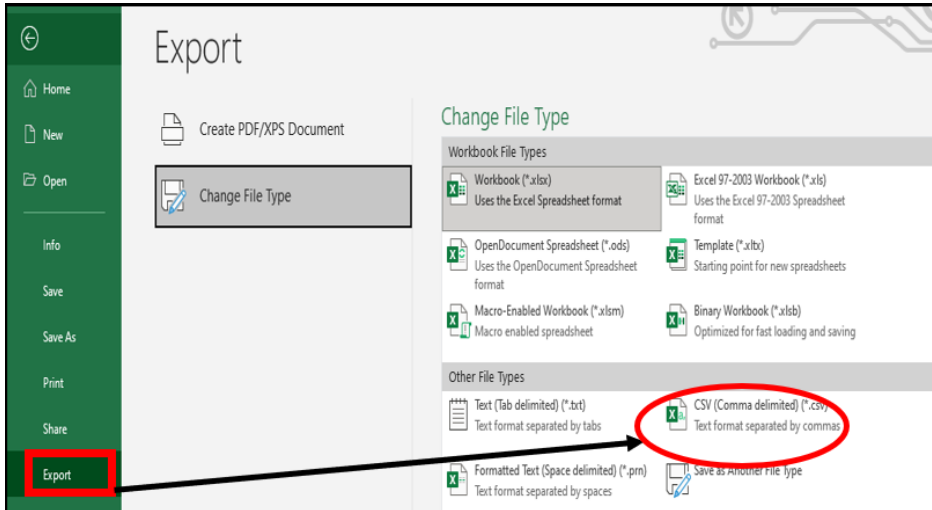
Figure 6. Preparing the .csv file.